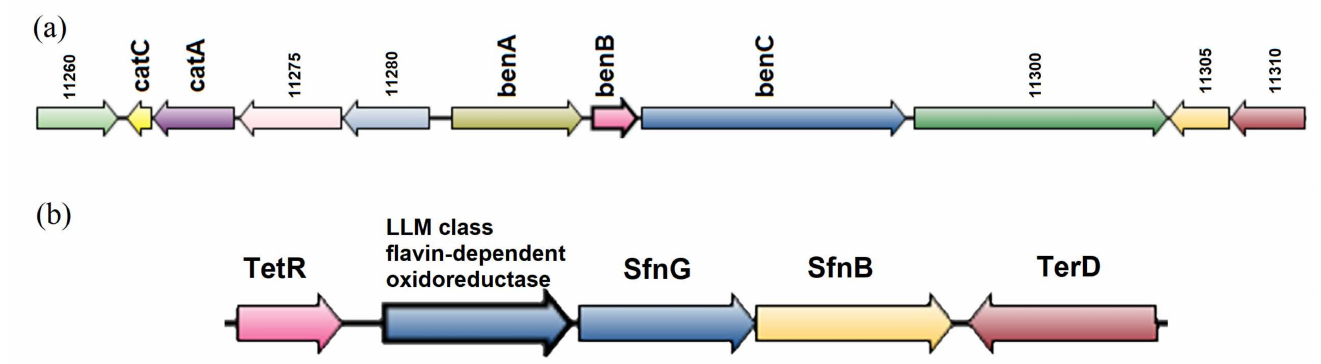
Figure 5. Genomic regions containing benzoate degradation genes ( a ) and the gene sfn B ( b ) tentatively involved in DBT desulfurization in Gordonia